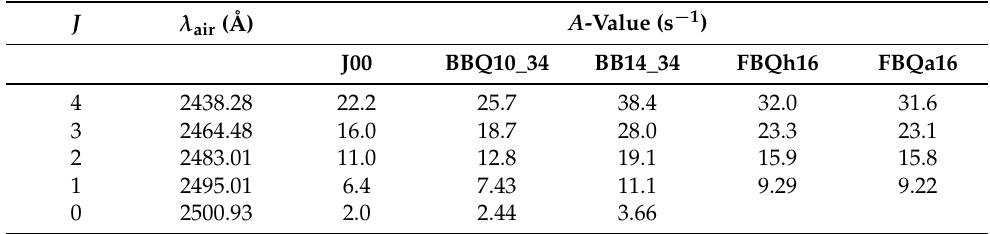
Table 1. A -value comparison for the 3d 5 4s 5 S 2 − 3d 6 5 D J transitions in [Fe III ]. A -values in